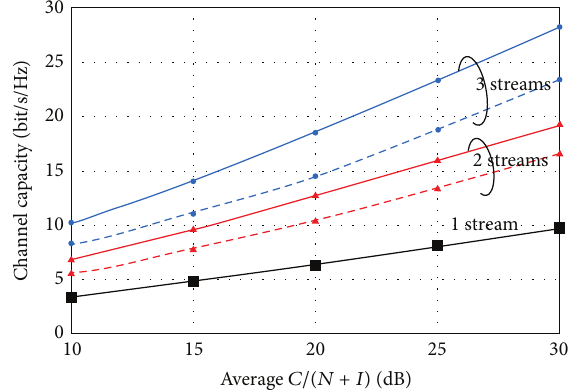
Figure 3: Channel capacity in accordance with spatially correlation and number of